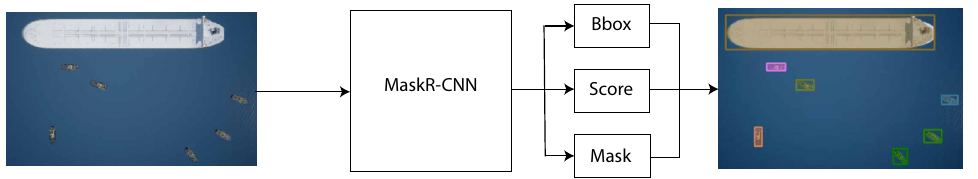
Figure 8. A high-level illustration of input and output of Mask R-CNN.